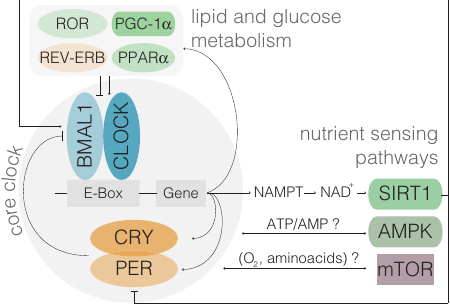
Fig. 1 Crosstalk between molecular components of circadian clock, nutrient-sensing, and metabolic pathways. Core clock proteins CLOCK/ BMAL1 (transcriptional activators) and PER/CRY (repressors) are engaged in an autoregulatory transcriptional/translational feedback loop leading to 24 h oscillations in gene expression, activity and protein levels. The molecular clock also regulates the rhythmic expression of genes involved in several cellular functions and nutrient-sensing pathways, which in turn feedback to the core clock machinery. CLOCK ( Clock ), BMAL1 ( Arntl ), PER ( Period ), CRY ( Cryptochrome ), SIRT1 (Sirtuin 1), AMPK (5 ’ AMP-activated protein kinase), PGC-1 α (PPAR γ co-activator 1a), mTOR (Mammalian target of rapamycin), ROR (RAR- Related Orphan Receptor), Rev-Erb ( Nr1d1 ), and PPAR (Peroxisome Proliferator Activated Receptor).